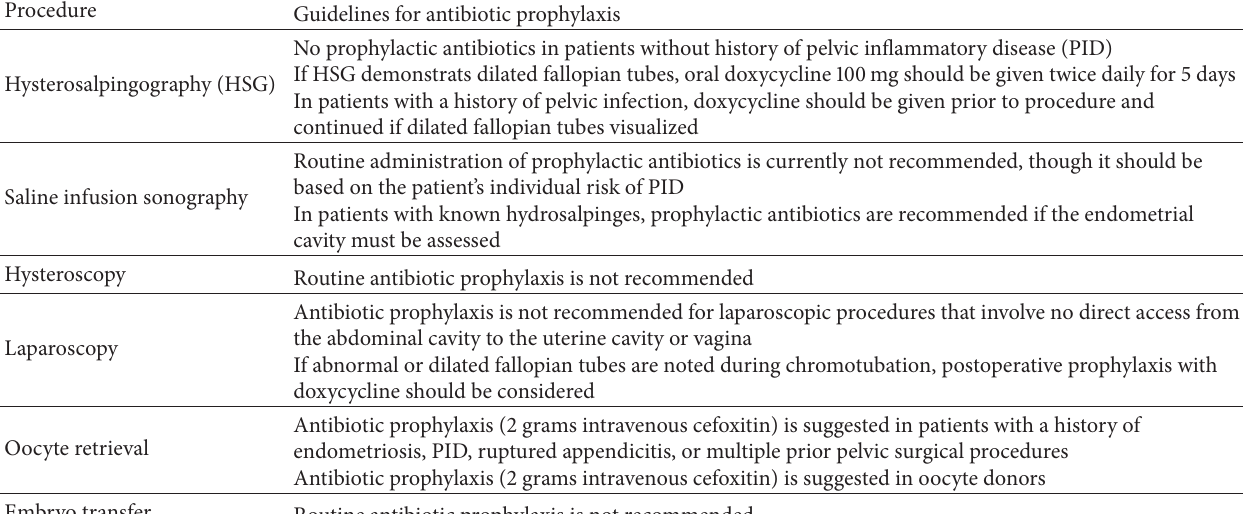
Table 1: Summary of evidence pertaining to antibiotic prophylaxis regimens for gynecologic procedures prior to and during